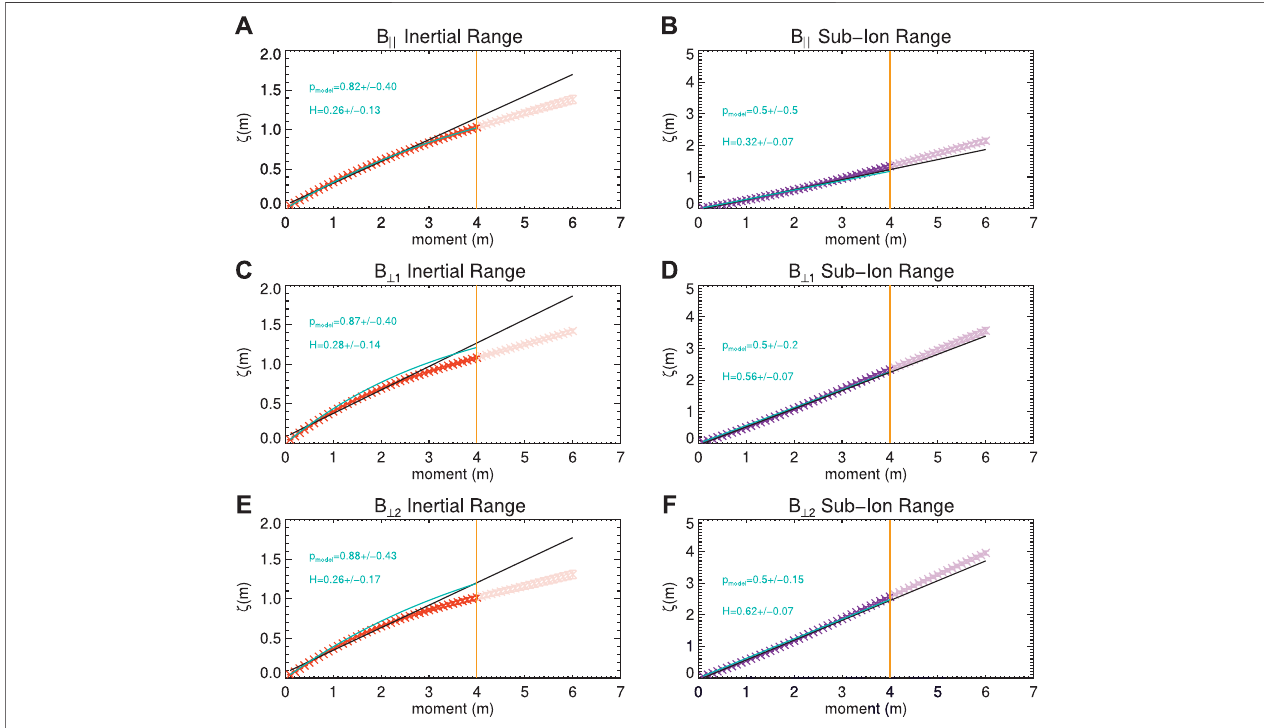
FIGURE 8 | Scaling exponents ζ as a function of the moment m for the magnetic fi eld. (A , B) denote the compressive component for the two ranges mentioned previously. (C , E) denote the scaling index for the inertial range for the two transverse components (D , F) denote the scaling exponent for the sub-ion range transverse